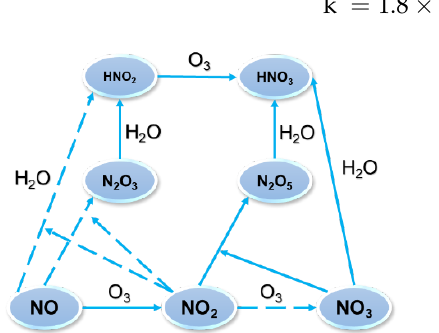
Figure 3. Schematic diagram of the main pathways of NOx oxidation by O 3 . Solid lines represent reactions always occurring and dashed lines represent reactions occurring under certain conditions. Adapted from [31] .